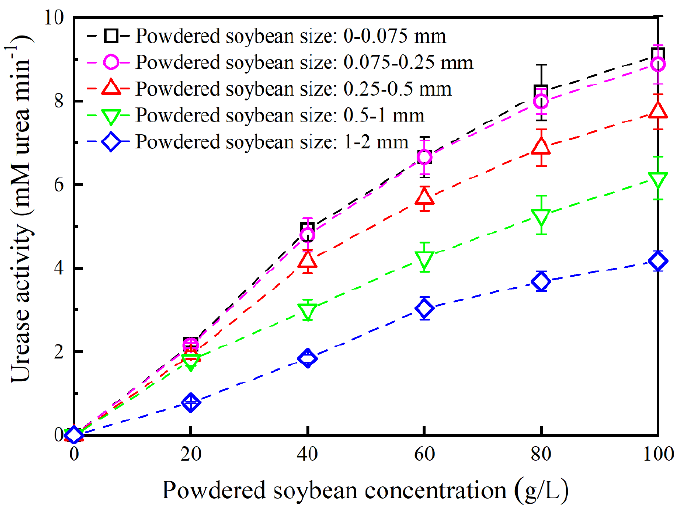
Figure 4. Effect of powdered soybean size and concentration on the soybean crude urease enzyme activity.